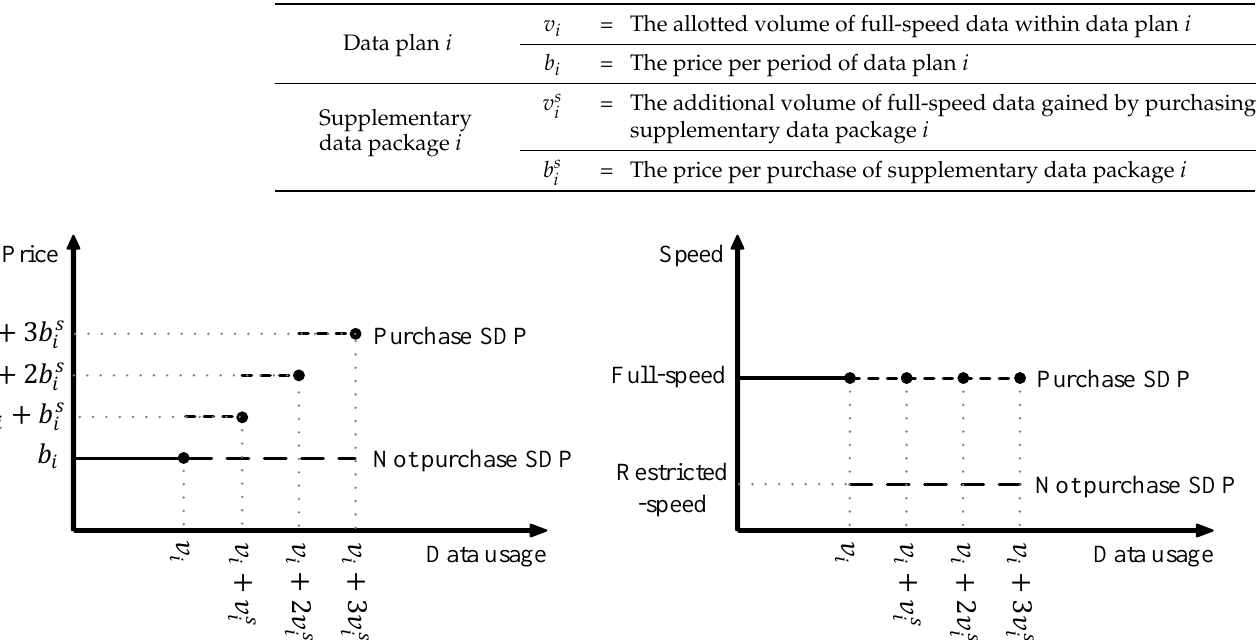
Table 1. Parameters of the data plan and supplementary data package (SDP).